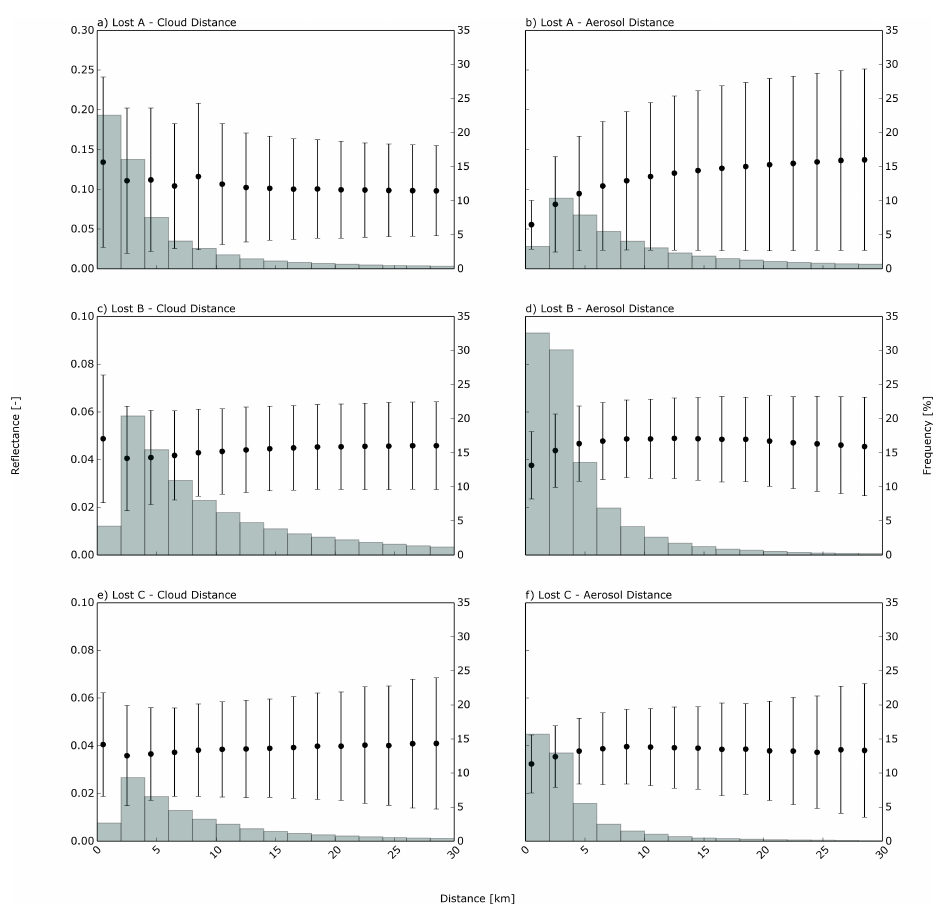
Figure 8. Reflectances and frequencies as functions of distance to nearest cloud pixel (left-hand column) and aerosol pixel (right-hand column) with lines representing the reflectances and bars the frequency of occurrence. The median of the reflectances is marked by dots and line ends correspond to the 1.5 inner-quartile range of the